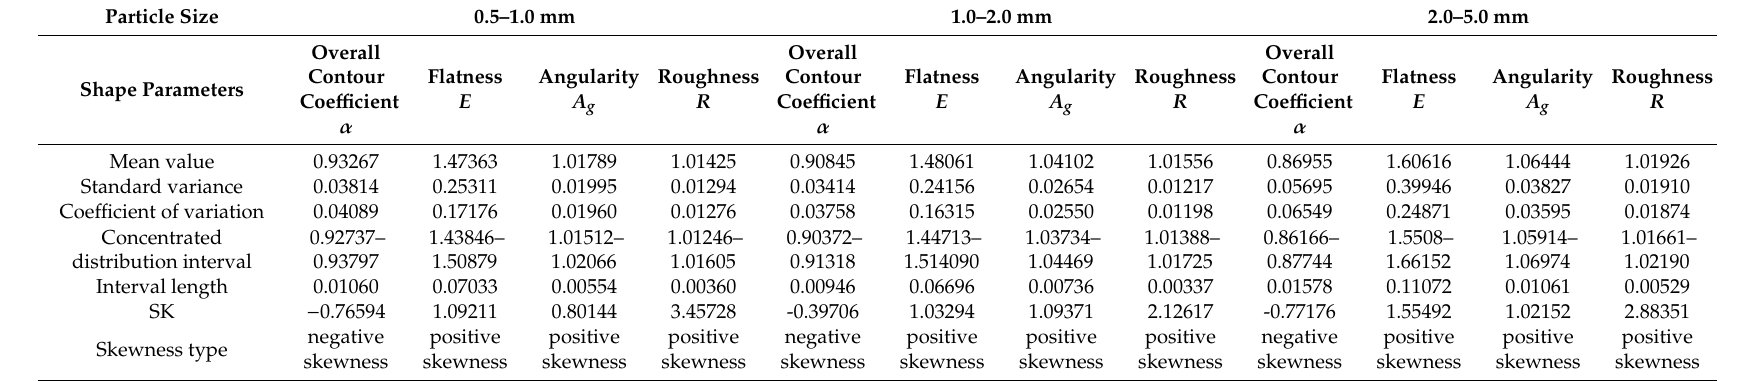
Table 4. Probability statistics table of the shape parameters of coral sand with di ff erent particle